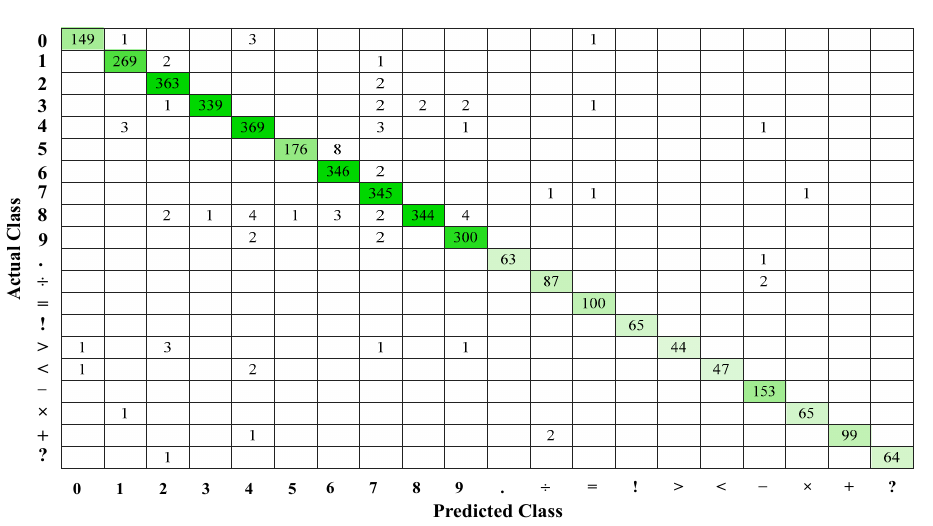
Figure 14. A confusion matrix of Type 1 classifier by proposed model.